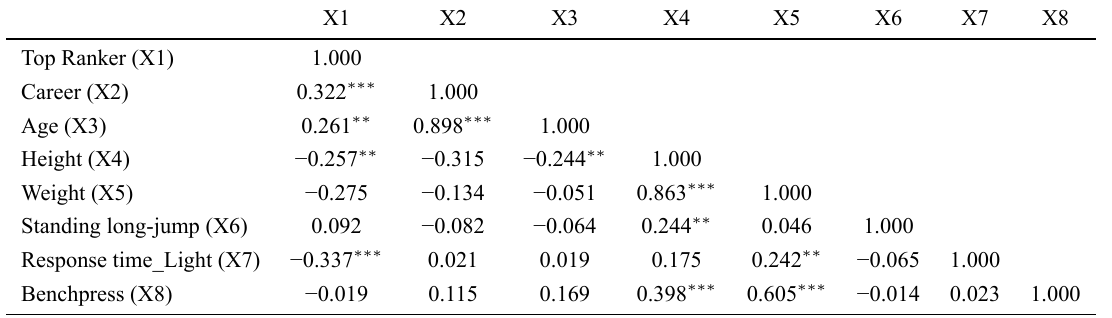
Table 3. Correlation of variables. This table shows the correlation between the variables. The variable “Top Ranker” is a dummy variable that a player was ranked at the top 1, 2, or 3 at the competition of the year as “1”, otherwise “0”. X1